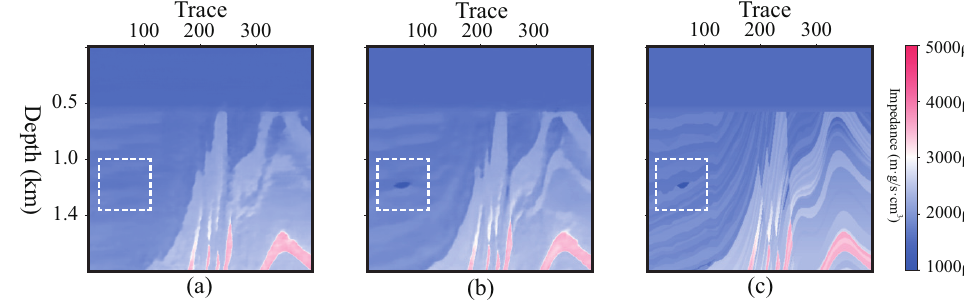
Figure 20. Self-attention contrast. ( a ) The result processed without the self-attention block, PCC = 0.9787, R 2 = 0.9004, SSIM = 0.4375 PSNR = 14.99 dB. ( b ) The result processed with the self-attention block, PCC = 0.9867, R 2 = 0.9376, SSIM = 0.8589, PSNR = 30.06 dB. ( c ) The label